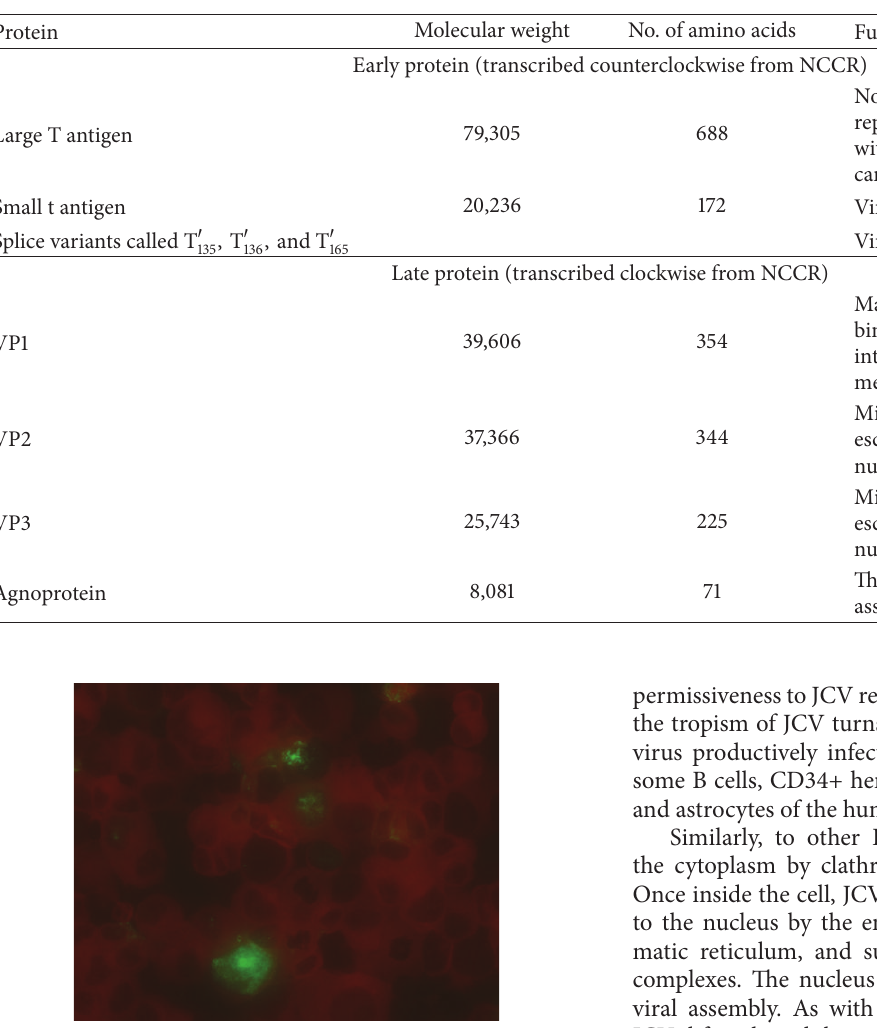
Table 1: Nonstructural and structural viral protein.